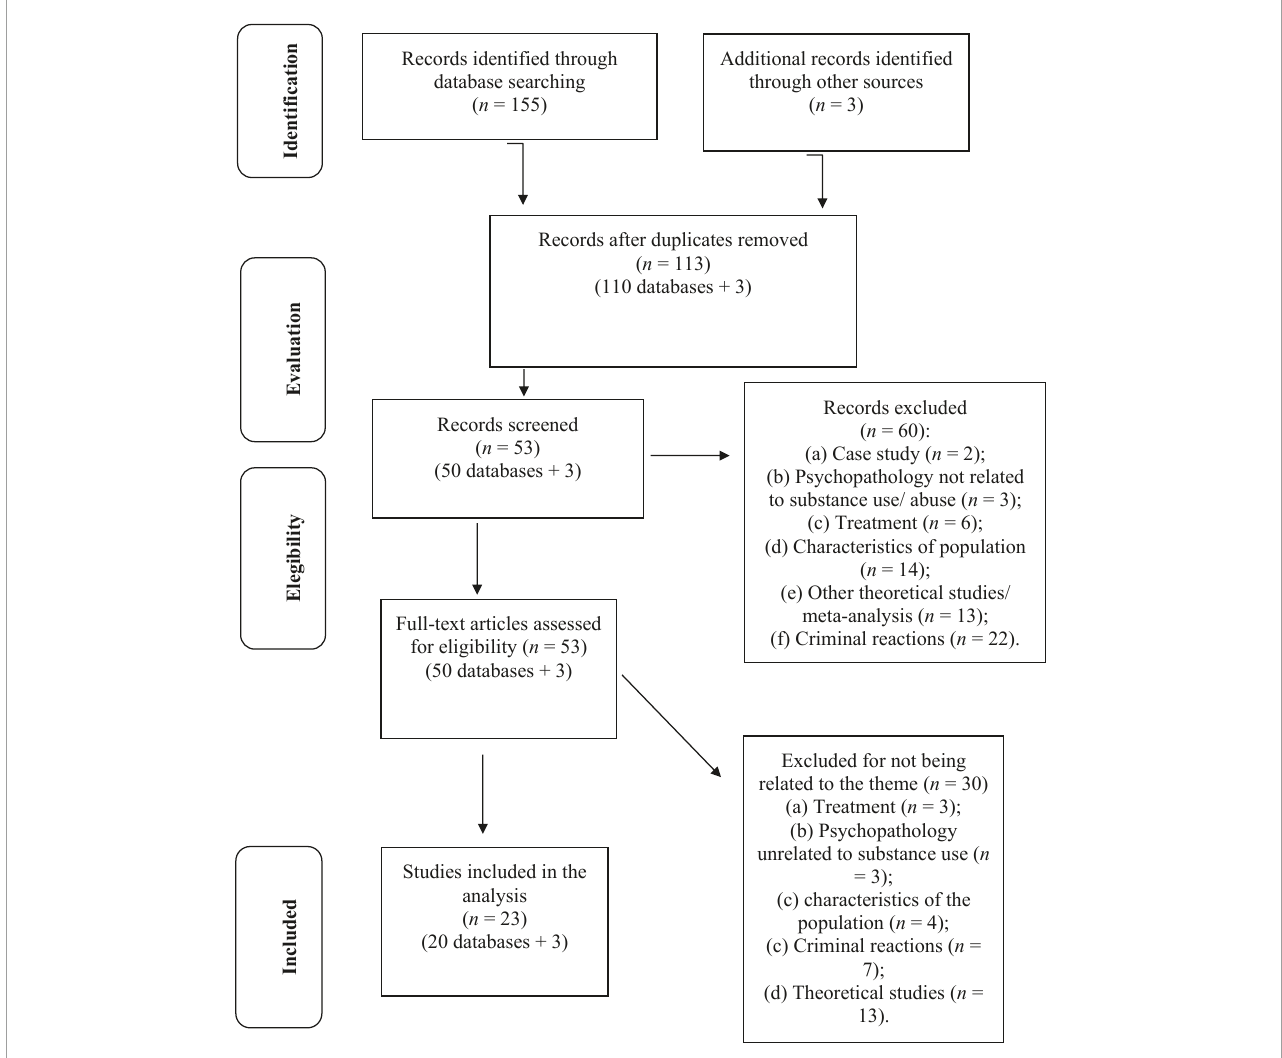
FIGURE1 Flowchart of literature